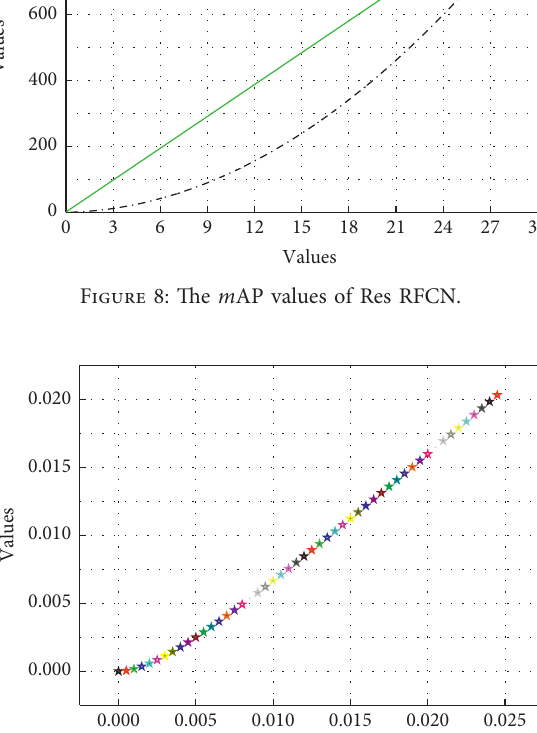
Figure 9: The m AP values of Res